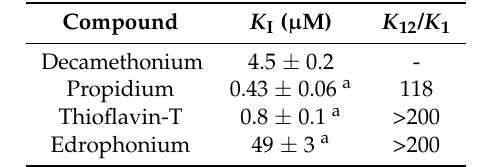
Table 1. Inhibition constants ( K I ) for four inhibitors with BChE and binding site competition ratios ( K 12 / K 1 ) for each inhibitor in the presence of decamethonium. A K 12 / K 1 ratio >> 1 denotes competition at the same binding site.